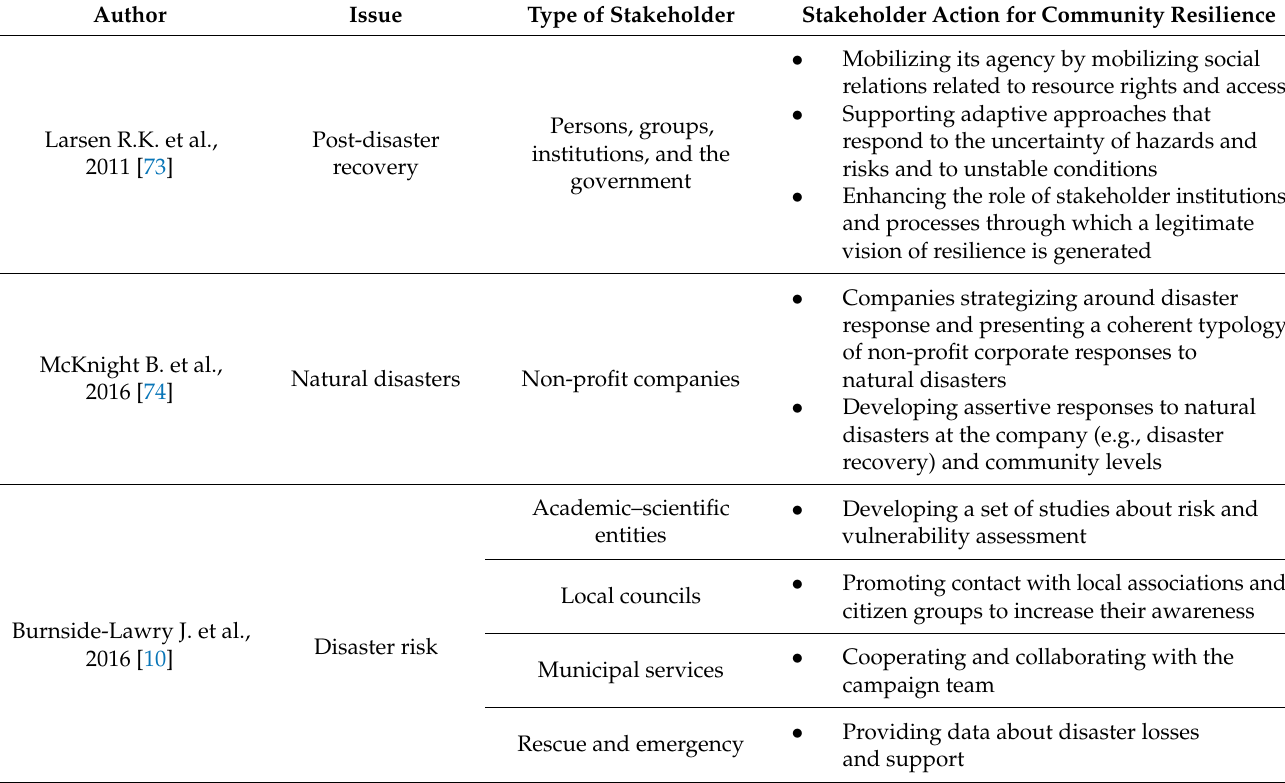
Table 1. Stakeholder actions for community